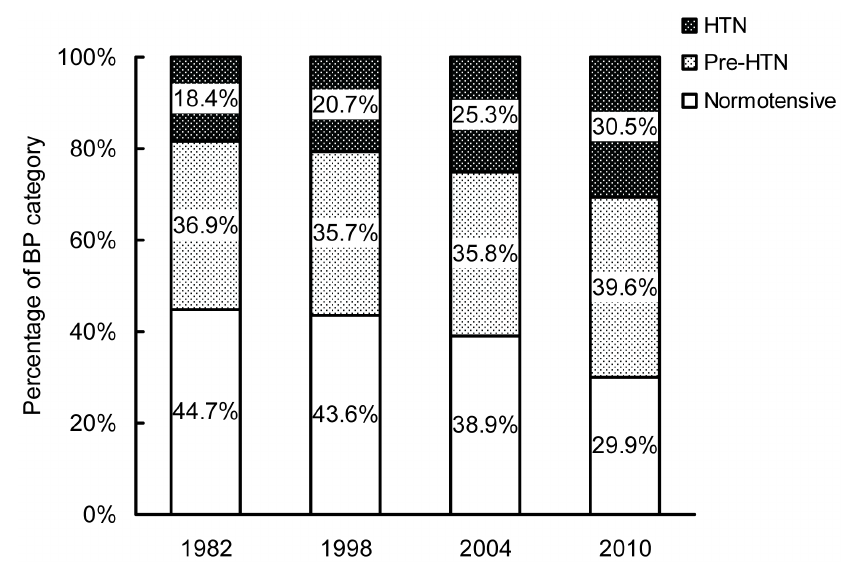
Figure 3. Change in distribution of BP categories, 1982 to 2010. 2009 were 82.3%, 38.2% and 59.4%, respectively [9]. The treatment and control among our rural population were even lower than those among a rural population in Nepal, 23.5% for treatment and 9.5% for control [28], and lower than those among the partially representative Chinese adults in 2009 (19.8% for treatment, 4.4% for control, and 26.6% for control in treatment, respectively, in rural, and 28.0% for treatment, 9.5% for control, and 47.3% for control in treatment, respectively, in urban) [19]. Table 4. Awareness, treatment and control of HTN for adults aged 35 to 64 years from 1982 to 2010. Characteristics 1982